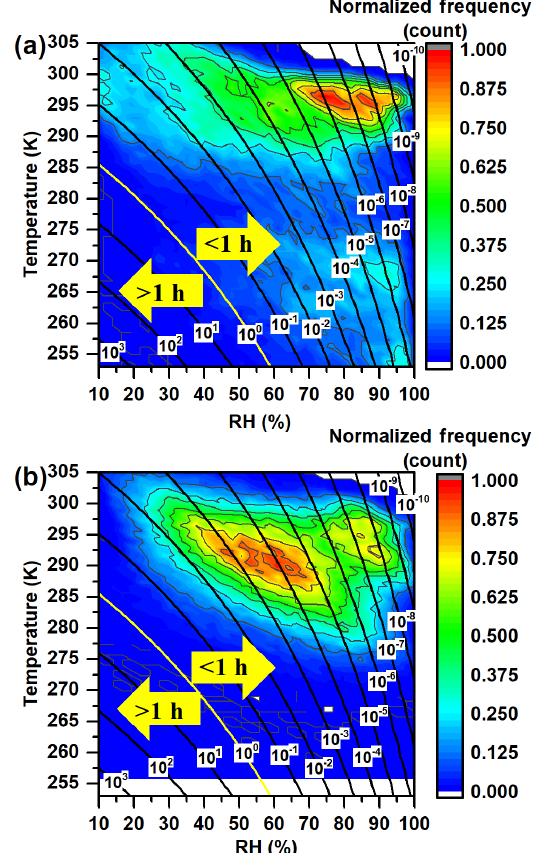
Figure 3. Six-hour normalized frequency counts of temperature and RH in the planetary boundary layer (PBL) (colour scale) to- gether with the mixing times for organic molecules within 200nm α -pinene SOA particles (contours). Panel (a) shows the conditions for January and panel (b) shows the conditions for July. Mixing times (contours) are reported in hours. Frequency counts in the PBL were only included for the conditions where the mass con- centration of total organic aerosol was > 0 . 5µgm − 3 at the surface. The viscosity parameterization used to calculate mixing times was based on α -pinene SOA generated using mass concentrations of ∼ 1000µgm − 3